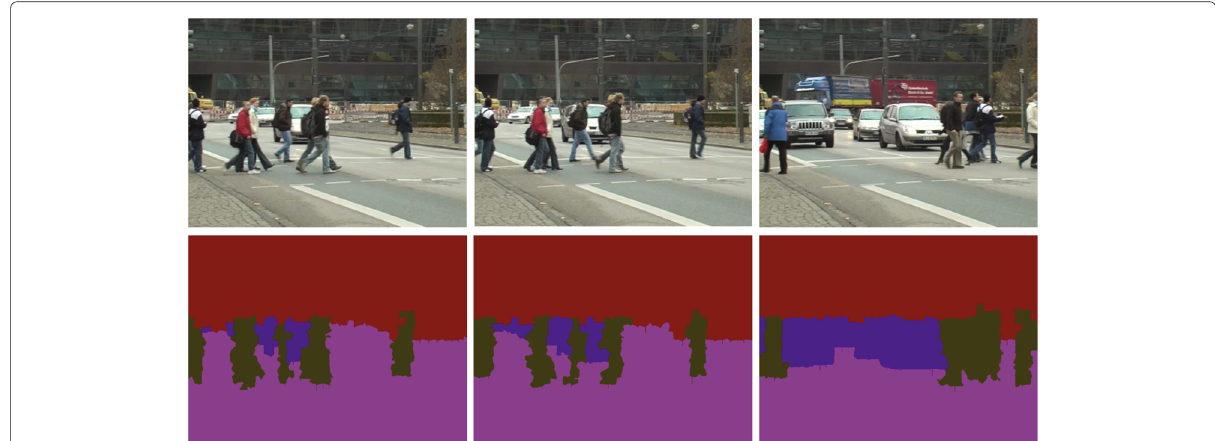
Fig. 7 Examples of scene-level labeling result on TUD dataset. Best viewed in